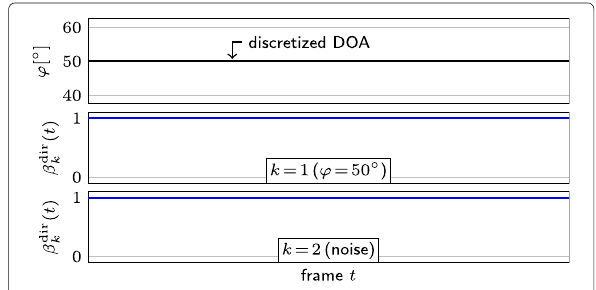
( t ) for J = 1 static speaker at ϕ = 50 ◦ . The Fig. 6 DTAs β dir k